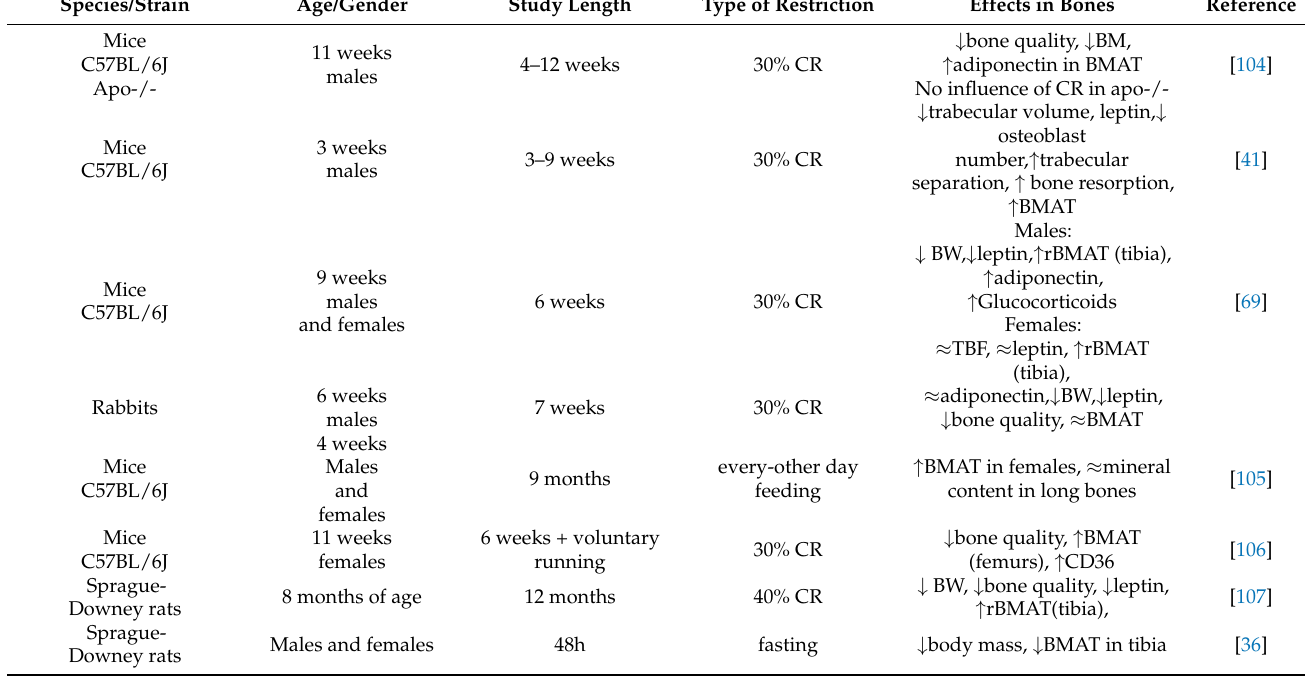
Table 3. CR in animal